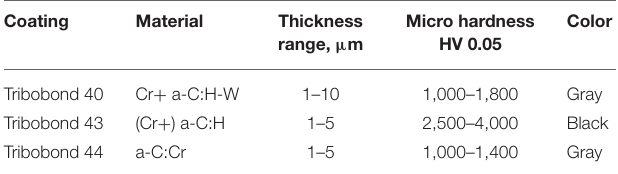
TABLE 1 | Physical properties of DLC